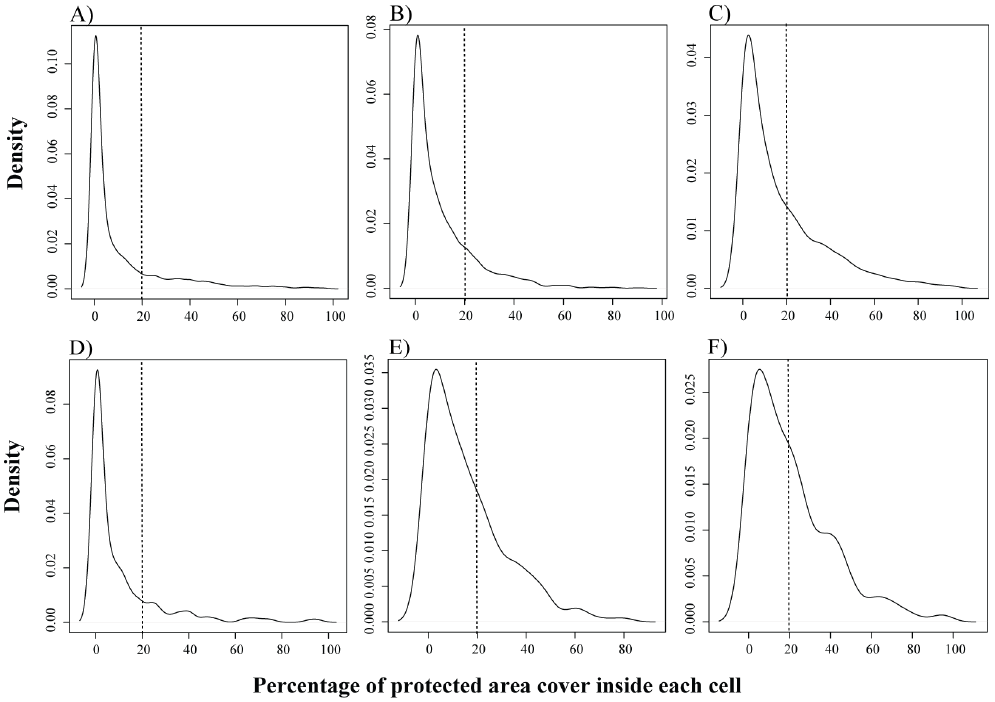
Figure 2 Figure 2. Kernel density plots showing the relative frequency of 50 × 50kmUTM grid cells that include a particular percentage of protected